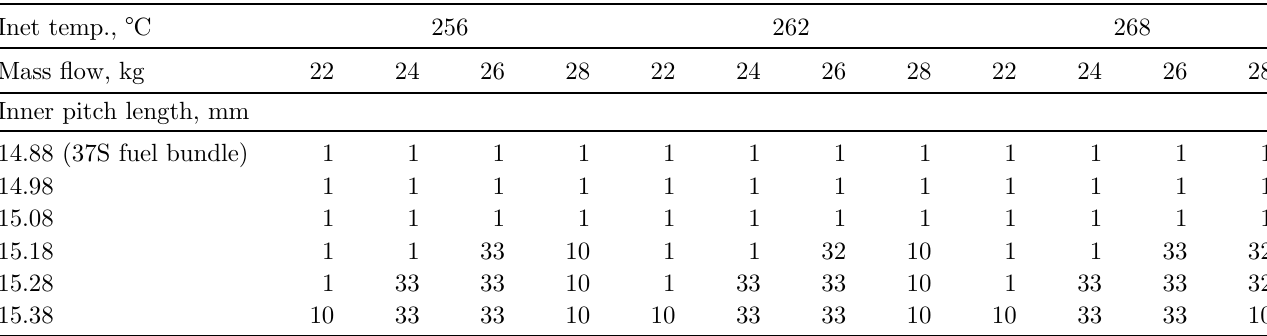
Table 2. Subchannel location of the 1st CHF occurrence for 3.3% crept pressure tube. Inet temp., ° C 256 Mass fl ow, kg Inner pitch length,